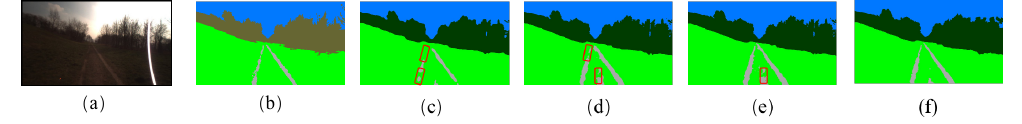
Figure 6. Visualization of ablation study. ( a ) IMAGE, ( b ) Ground Reference, ( c ) ResNet101, ( d ) ResNet101+Feature Aggregation, ( e ) Swin-S, ( f ) SwinS+FeatureAggregation.